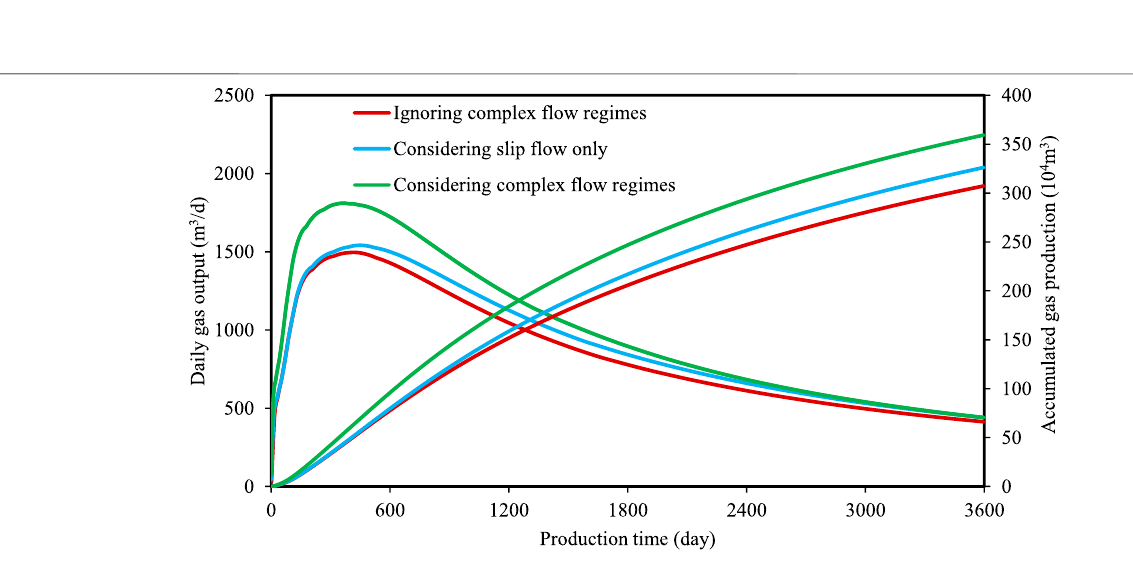
Frontiers in Earth Science |